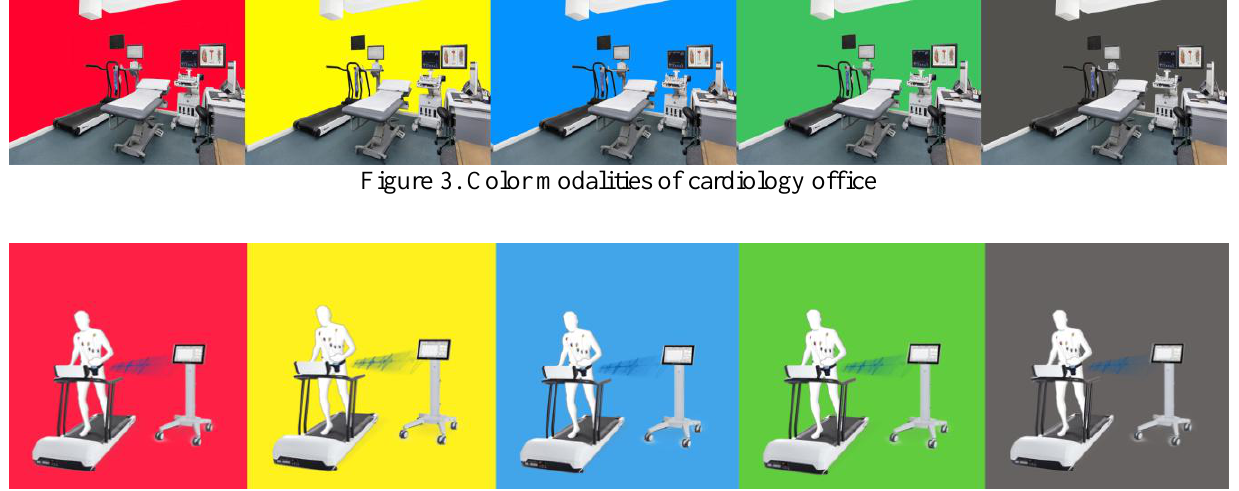
Figure 4. Color modalities of treadmill